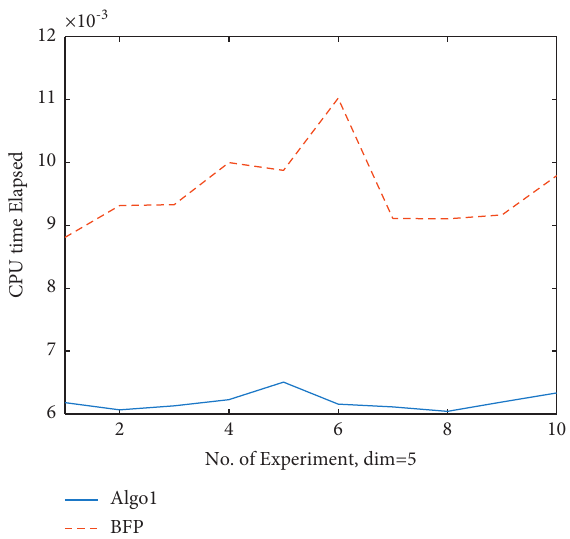
Figure 8: CPU time vs no. of iteration for dimension 5.